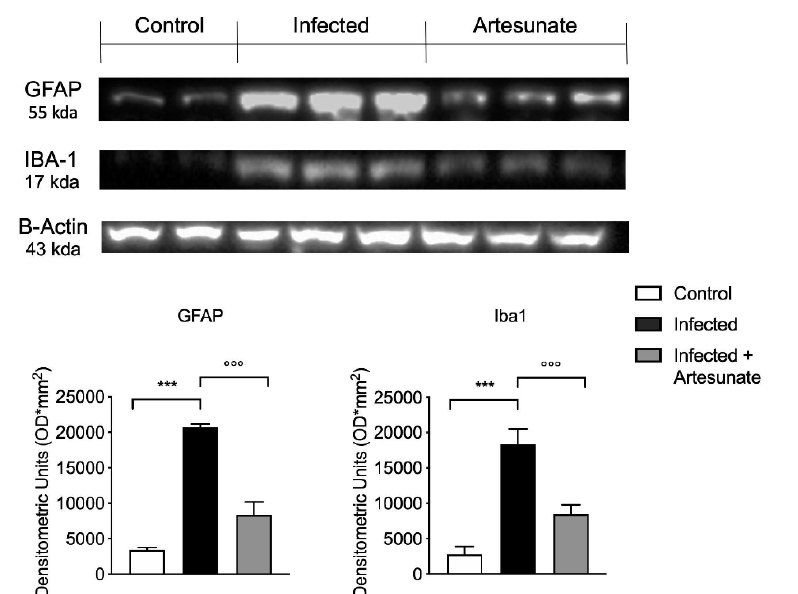
Figure 6. Western blot analysis of glial fibrillary acidic protein (GFAP) and ionized calcium binding adaptor molecule 1 (Iba1) expression in spinal cord tissue. Data are expressed as mean ± SEM from N = 10 mice for each group. *** p < 0.001 vs. control group; °°° p < 0.001 vs. infected group.